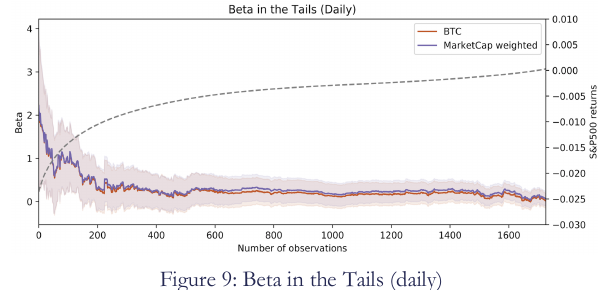
Figure 9: Beta in the Tails